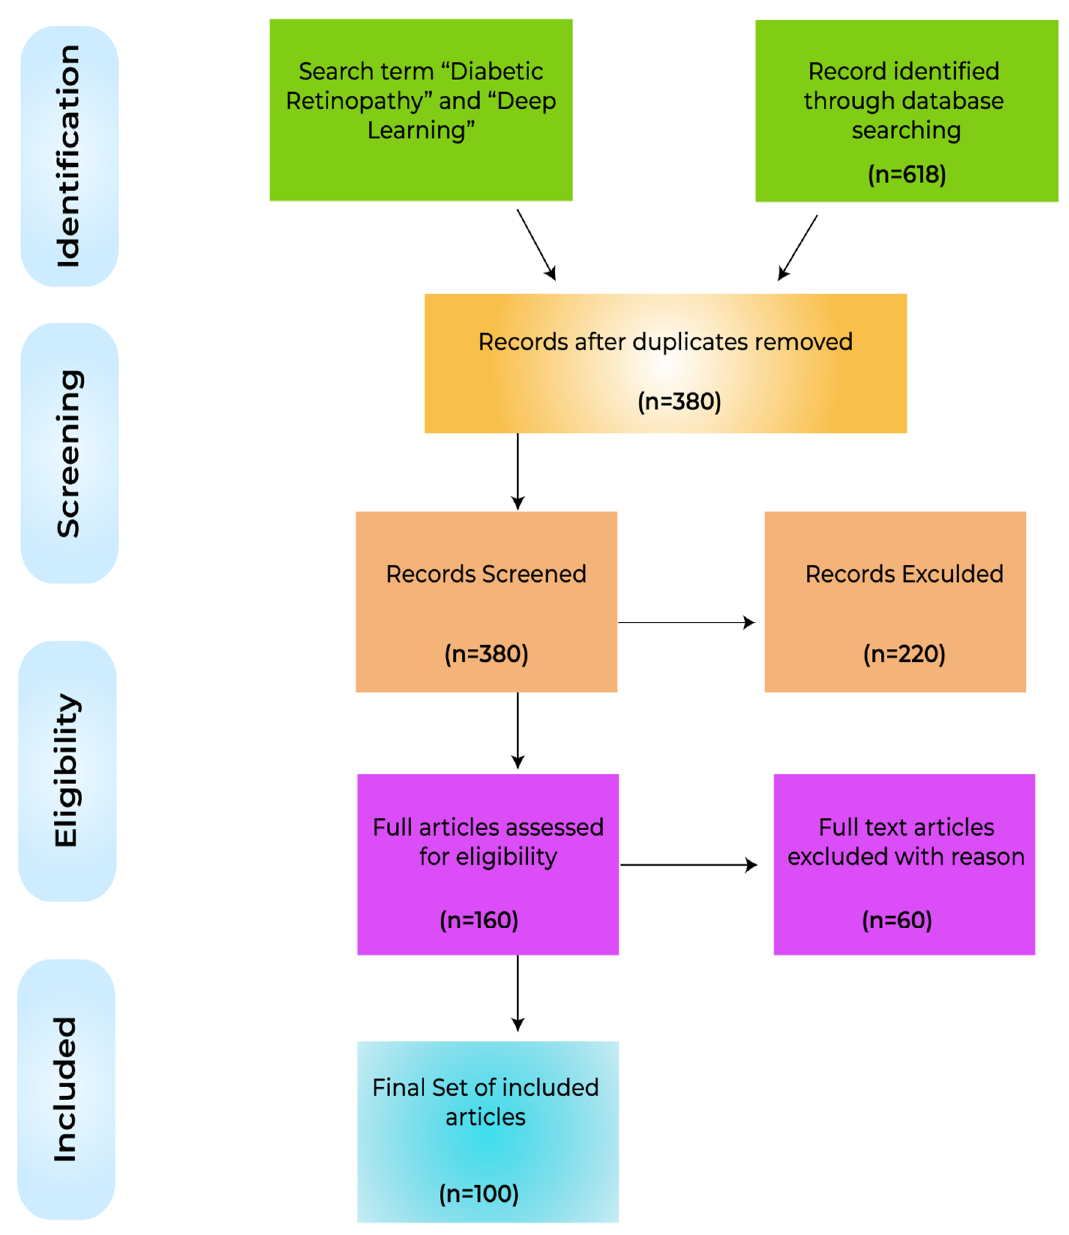
Figure 2. Flow diagram of the PRISMA approach used in the execution of the review.